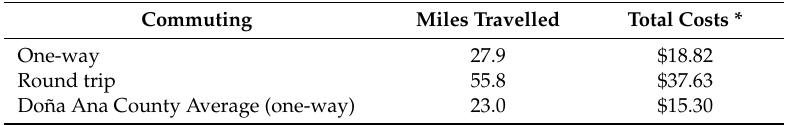
Table 6. Commuting cost to the traveller associated with travelling by personal vehicle.